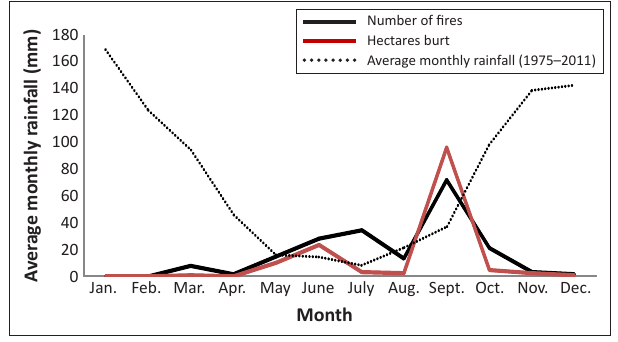
FIGURE 3: Number of fires and hectares burnt at Roburnia Plantation in